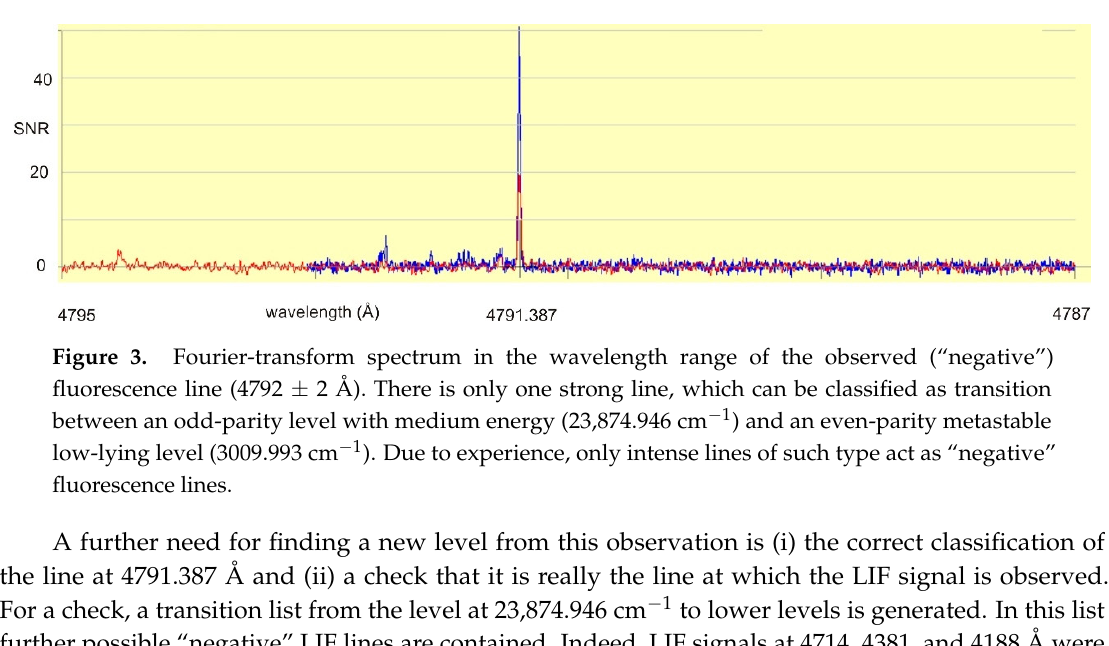
Figure 4. Simulation of the observed hf pattern of the line at 5683.40 Å assuming different values for the total angular momentum of the new fine structure level.